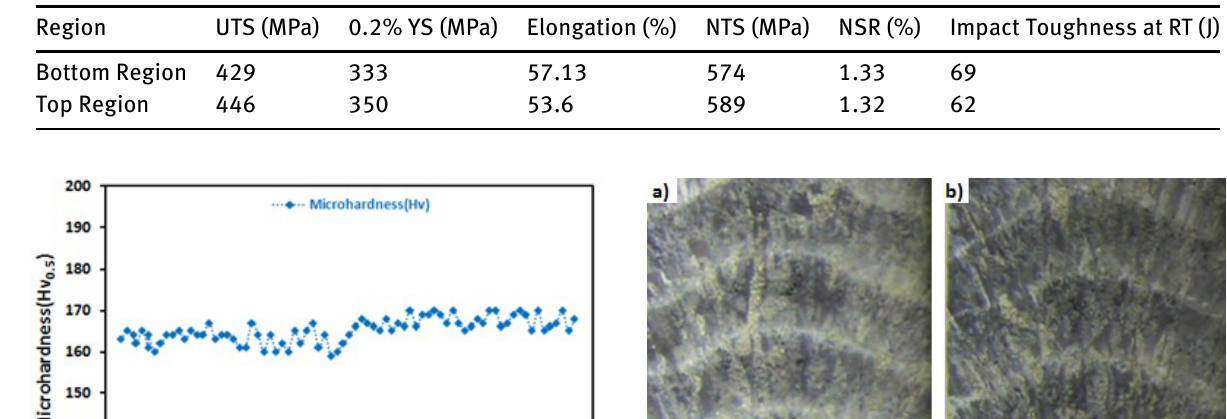
Table 5: Tensile and impact toughness properties of cylindrical component.